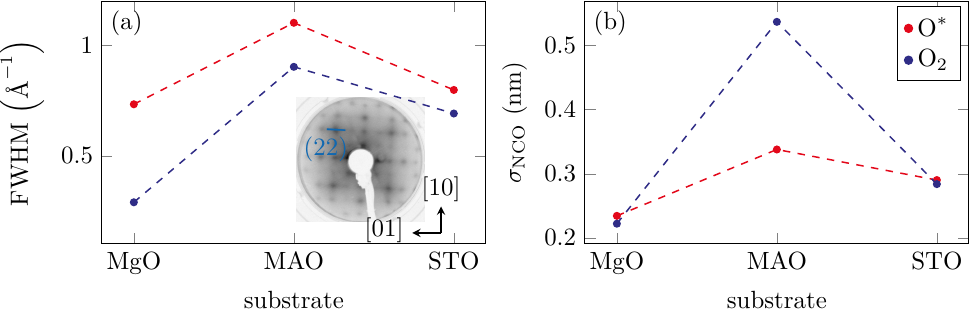
Figure 2. ( a ) FWHM of the ( 22 ) reflex with respect to the substrate (cf. inset). The FWHM was the highest for the MAO substrates. In general, the films with molecular oxygen exhibit a smaller FWHM than those with oxygen radicals. ( b ) RMS surface roughness σ NCO of NCO. Here, also the surface roughness was the highest for the MAO substrate. In contrast to the FWHM, the surface roughness was higher for the films prepared with O 2 than for the O ∗ films.